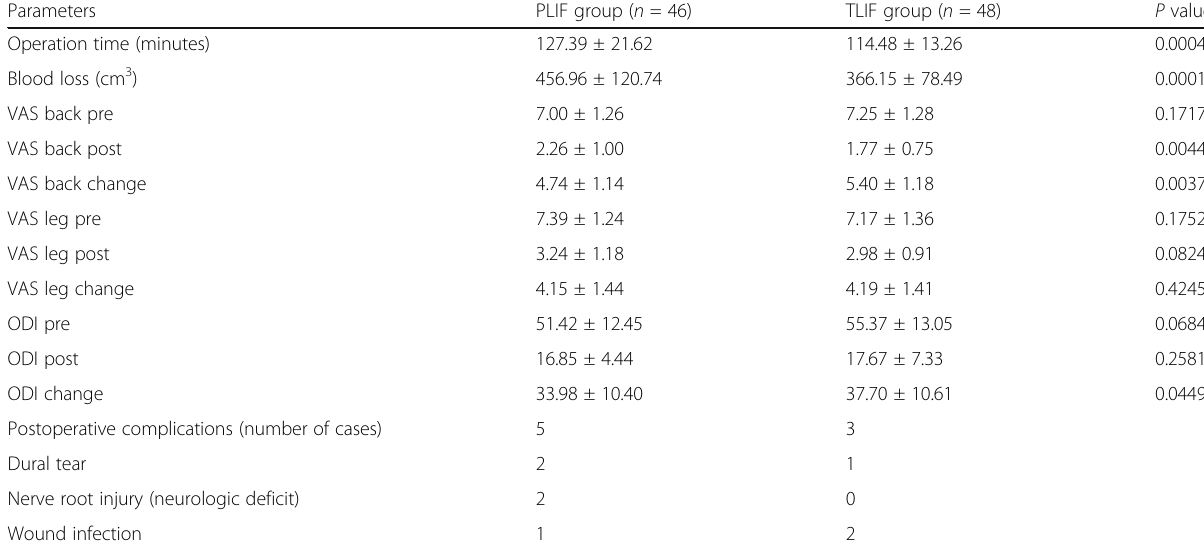
Table 2 Comparison of surgical outcomes between PLIF and TLIF